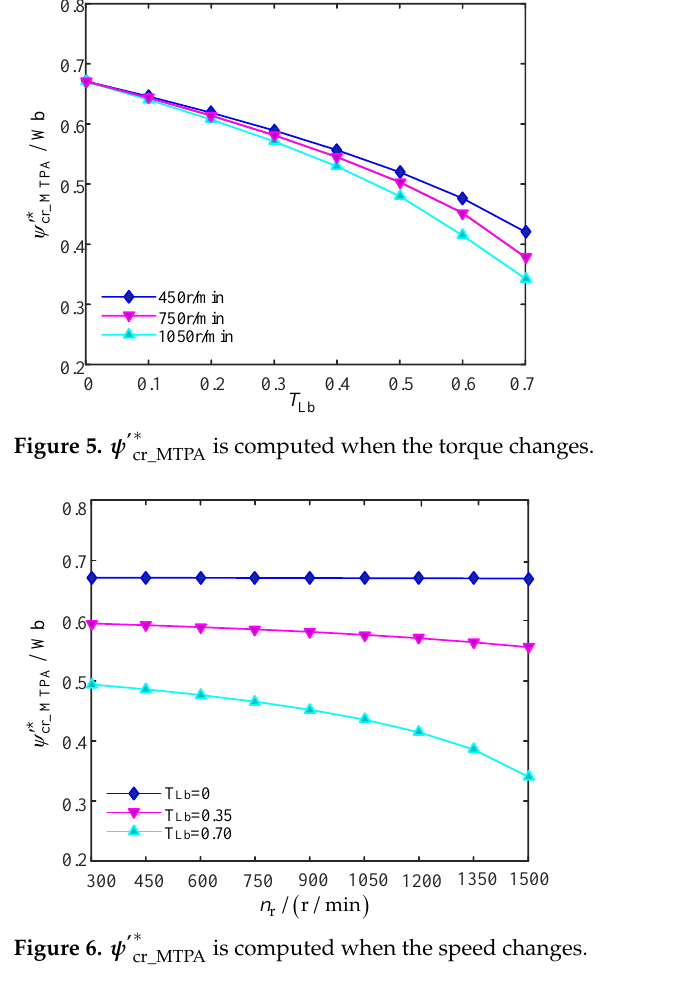
when the speed and torque vary. c r _ M T P A